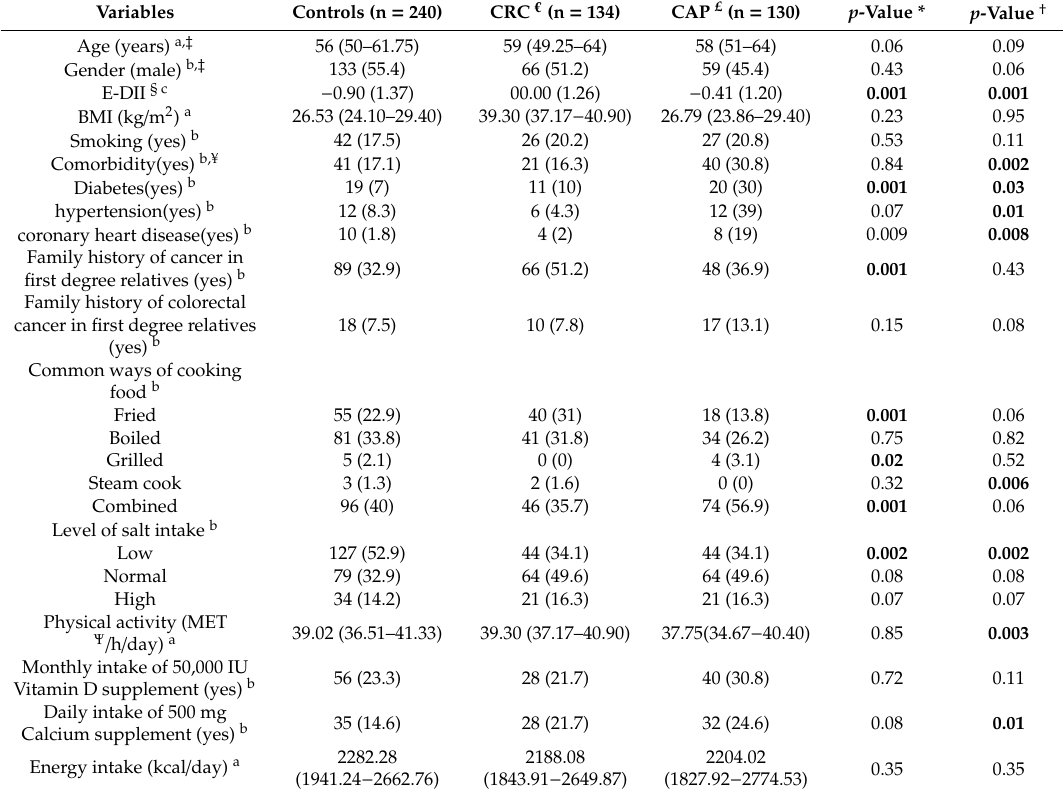
Table 1. The main characteristics of the participants, Iranian colorectal cancer (CRC) and colorectal adenomatous polyps (CAP) case-control study, Tehran, 2017–2018.